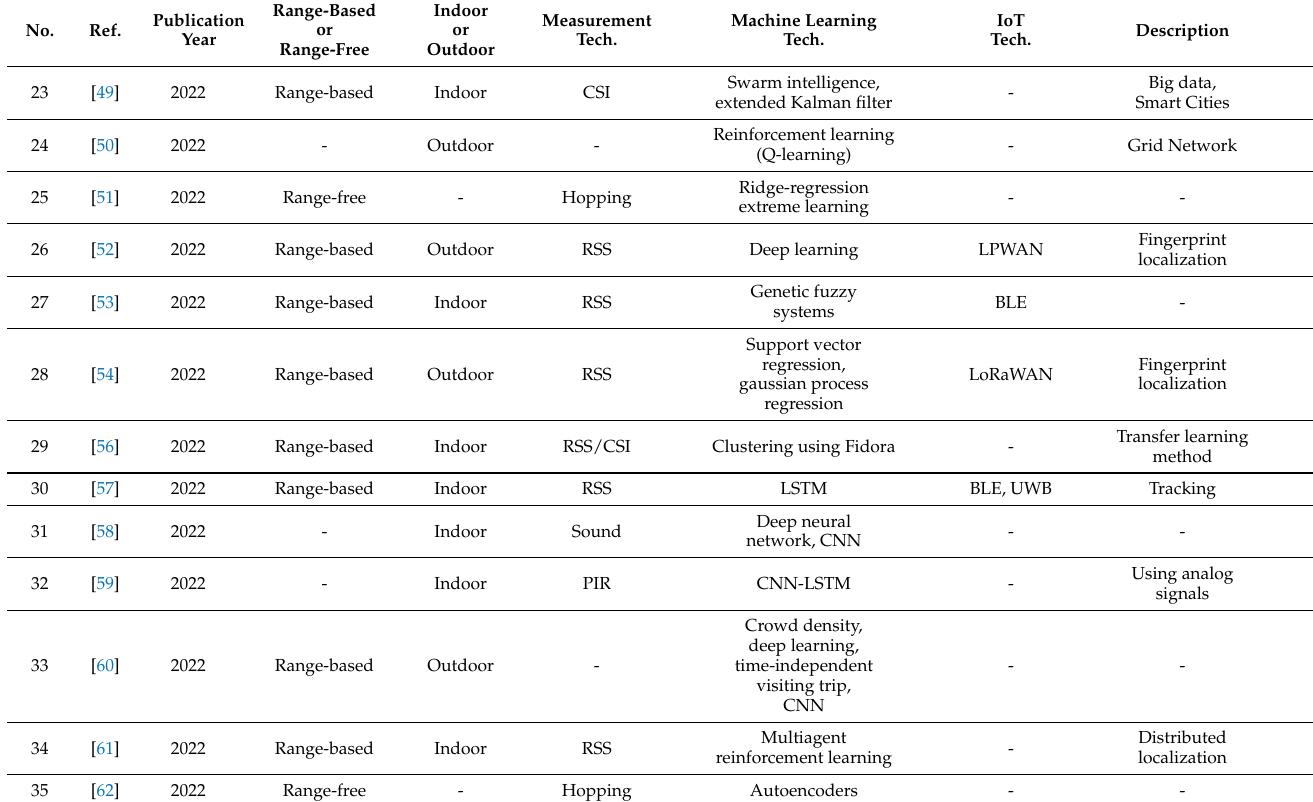
Figure 3 further categorizes the literature based on the learning algorithms used.